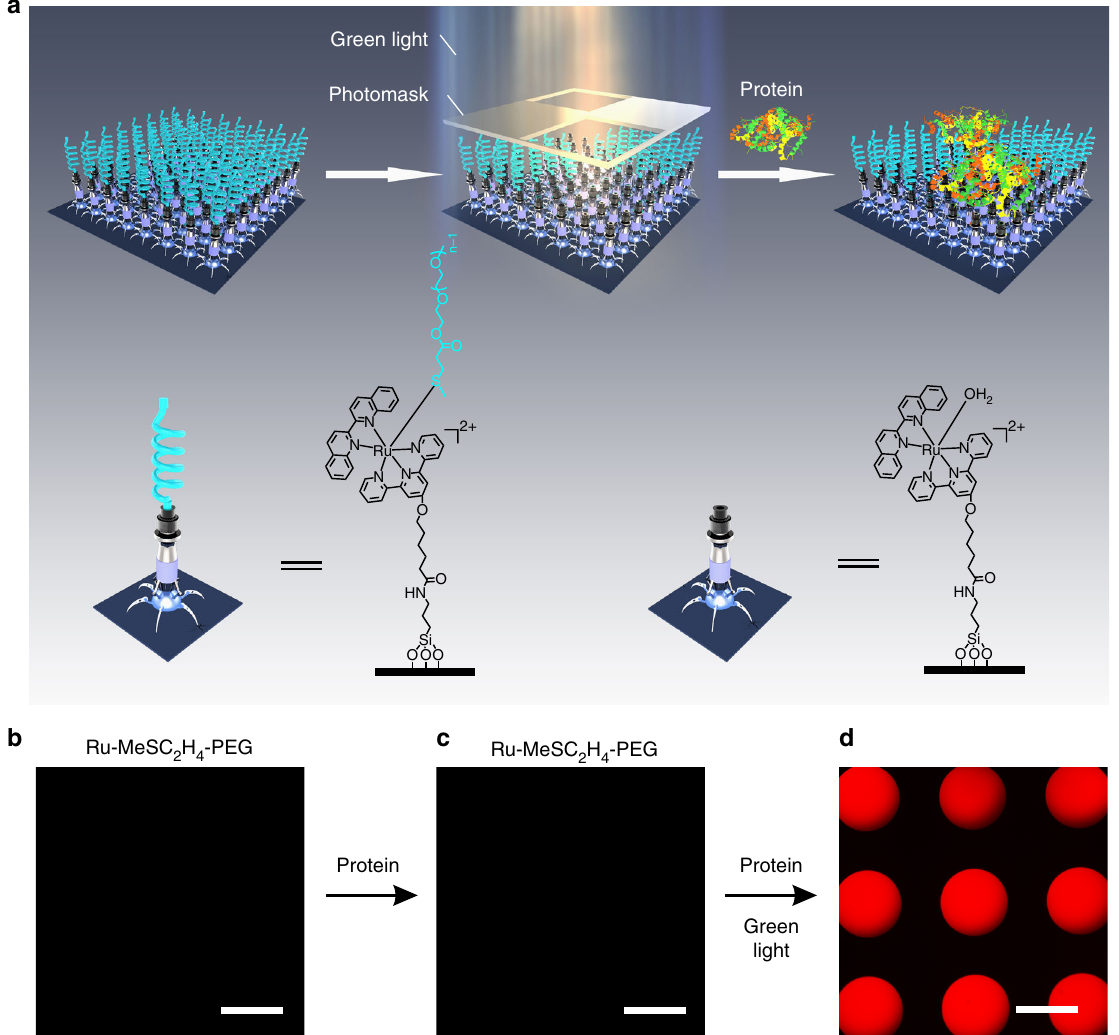
Fig. 4 Controlling protein adsorption with visible light. a Schematic illustration of the conversion of a protein-resistant surface into a protein-adsorptive surface with light. The fl uorescent images of the b Ru-MeSC 2 H 4 -PEG-modi fi ed surface, c Ru-MeSC 2 H 4 -PEG-modi fi ed surface after immersion in a solution of fl uorescently labeled BSA (0.5 mg mL – 1 ) for 2 h and washing with an aqueous solution of NaCl (1 mM, pH = 9), and d protein pattern fabricated using the approach in a . Scale bars are 300 µ